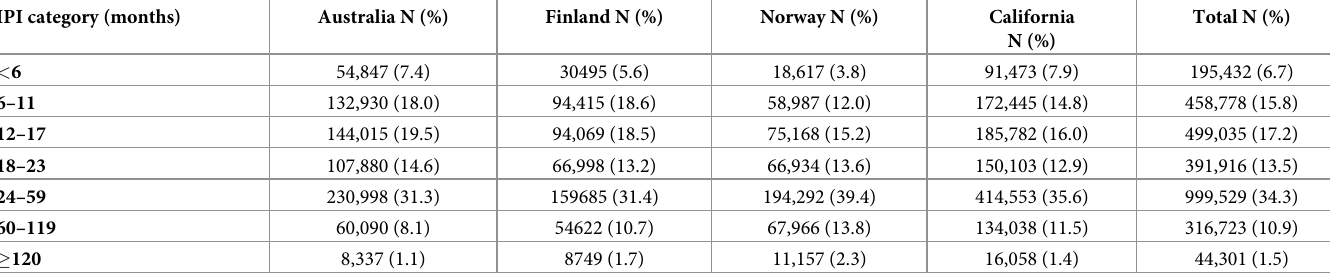
Table 2. Interpregnancy interval distribution for births in within-women analyses across the four countries (n = 2,905,703). IPI category